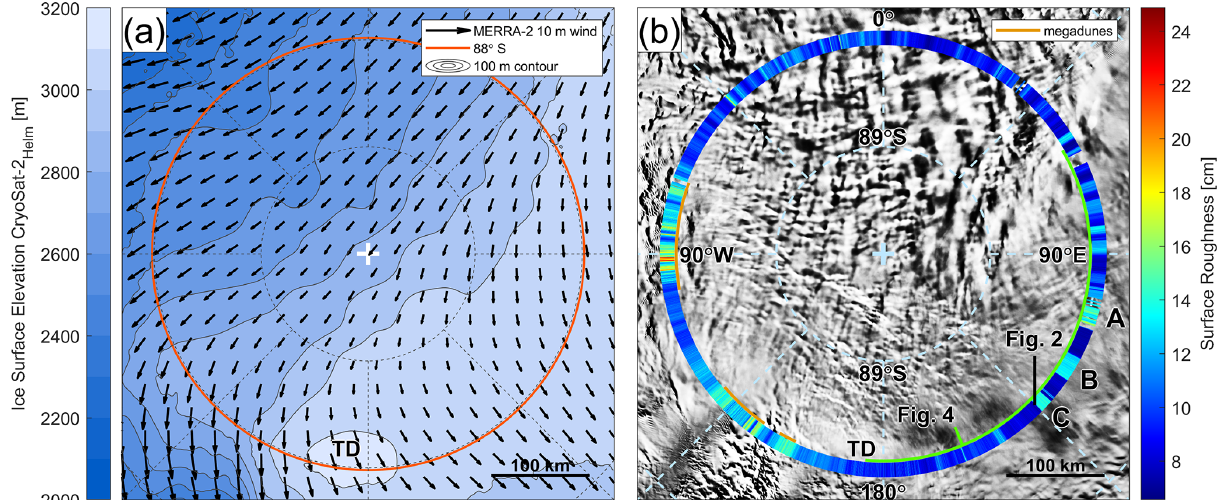
Figure 3. (a) Ice surface elevation from CryoSat-2 (Helm et al., 2014a) and 26-year 10m average wind speed from MERRA-2 (e.g., Gelaro et al., 2017). The red line marks the location of 88S ◦ S airborne geophysical data collection. TD is Titan Dome. (b) Ice surface roughness from 2014 ATM data (Studinger, 2014, updated 2018). The background image is a MODIS mosaic of Antarctica 2013–2014 (Haran et al., 2014) using MODIS data between November 2013 and March 2014. Locations of megadune fields are marked in orange, and roughness features A, B, and C refer to Fig. 4b. The location of the segment with a smooth surface in 2016 and 2017 between 175 ◦ W and 60 ◦ E that is discussed in Sect. 3.4 and shown in Fig. 4 is marked by a green